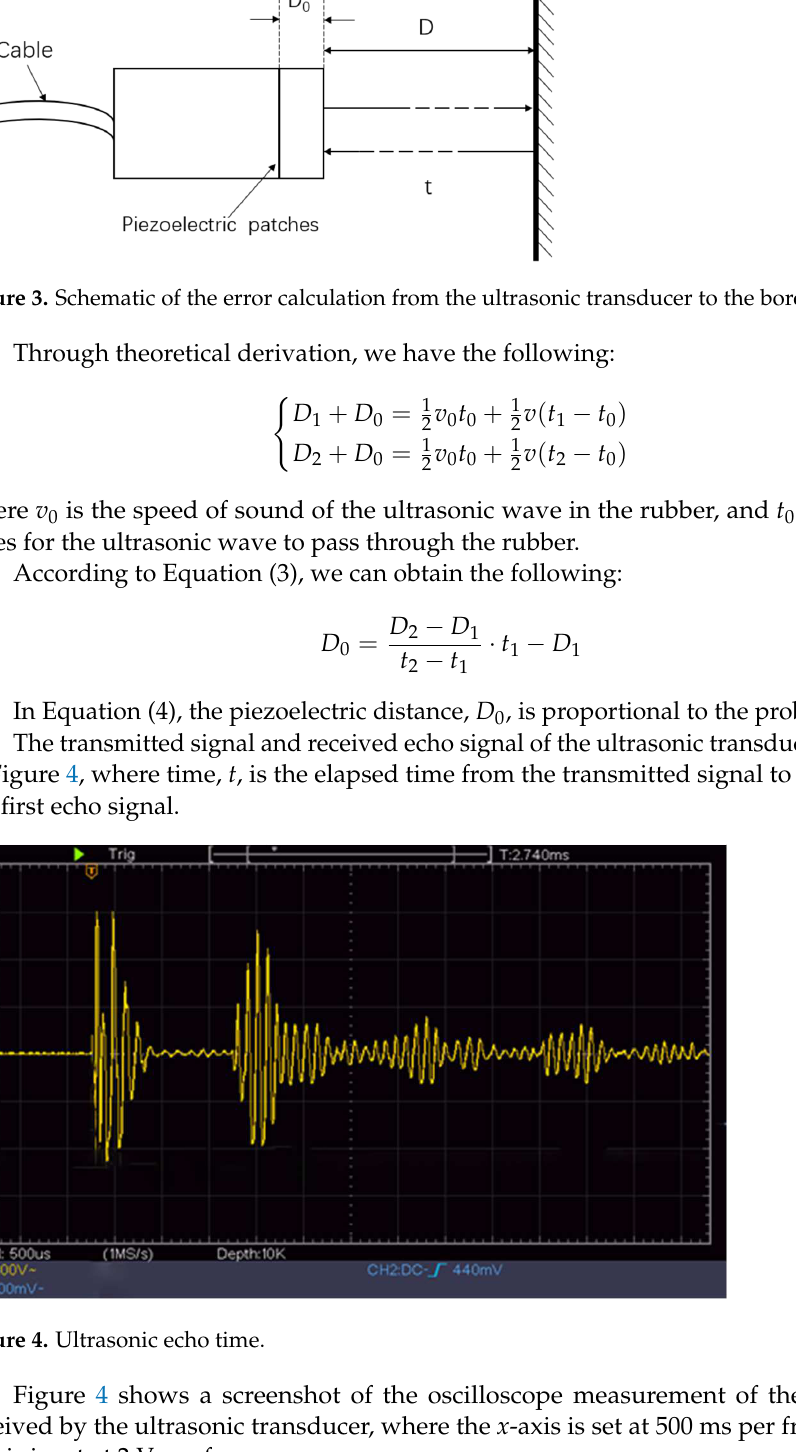
Figure 3. Schematic of the error calculation from the ultrasonic transducer to the borehole wall.